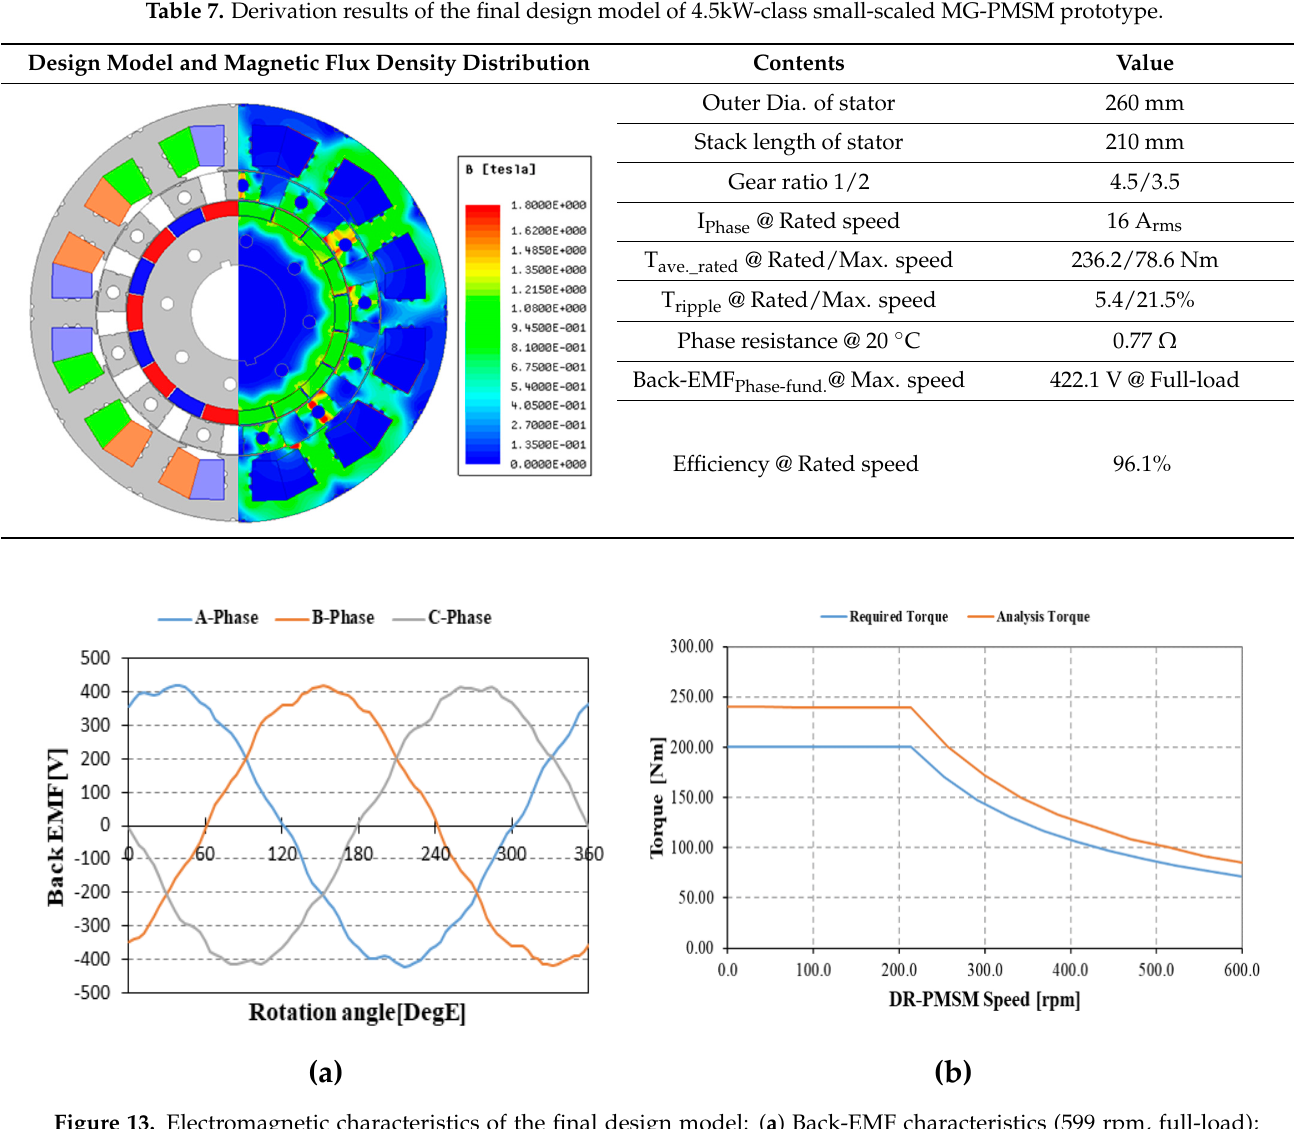
Figure 13. Electromagnetic characteristics of the final design model: ( a ) Back-EMF characteristics (599 rpm, full-load); ( b ) Torque characteristics.